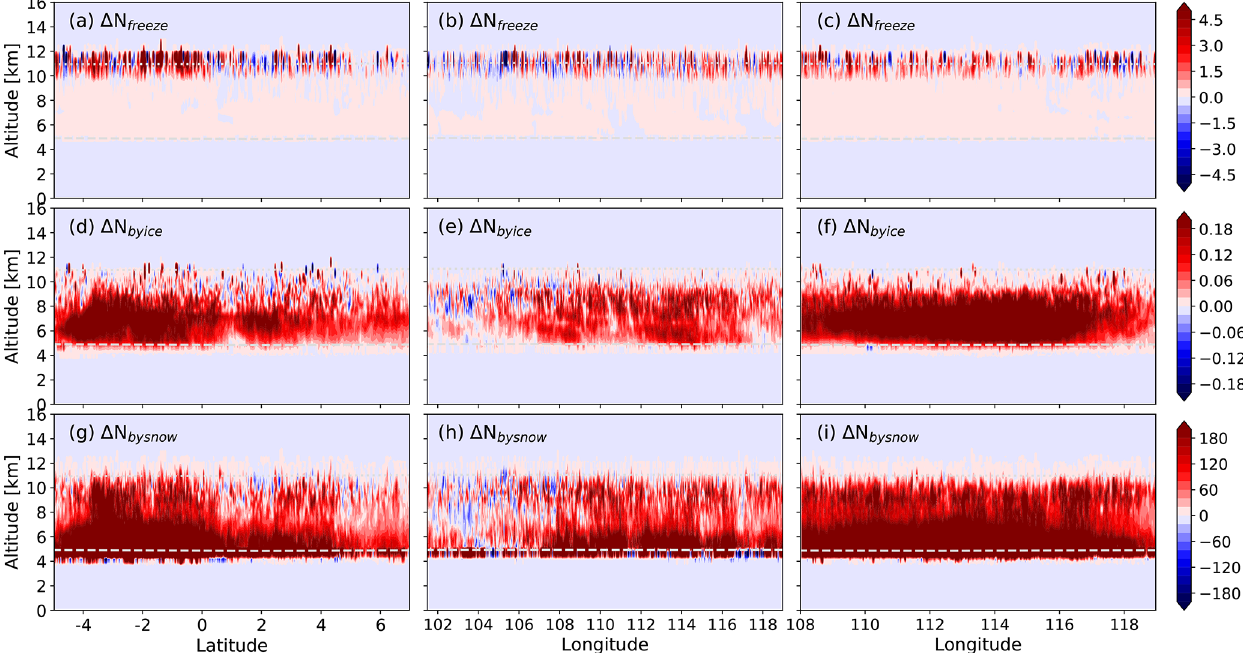
Figure A2. Differences (FIRE − NOFIRE) in monthly and zonal (Region 1) or meridional (Regions 2 and 3) mean rates (kg − 1 s − 1 ) of droplet number changes via (a–c) cloud droplet freezing, (d–f) droplet accretion by ice, and (g–i) droplet accretion by snow in (a, d, g) Region 1, (b, e, h) Region 2, and (c, f, i) Region 3. These are averages inside grid boxes with rates > 0.